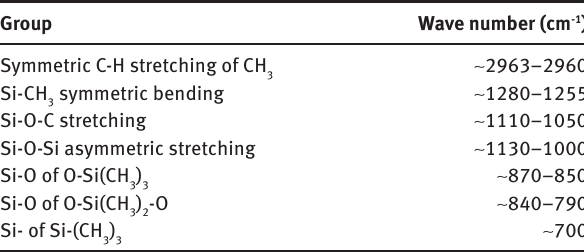
Table 3: Important groups in SiR and relevant absorption bands.